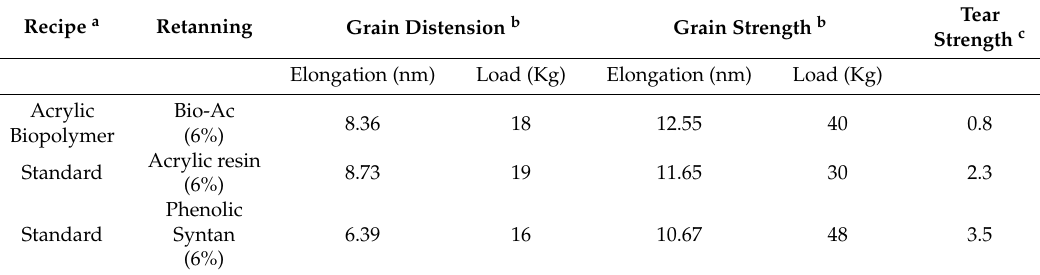
Table 5. Mechanical Tests for Crust